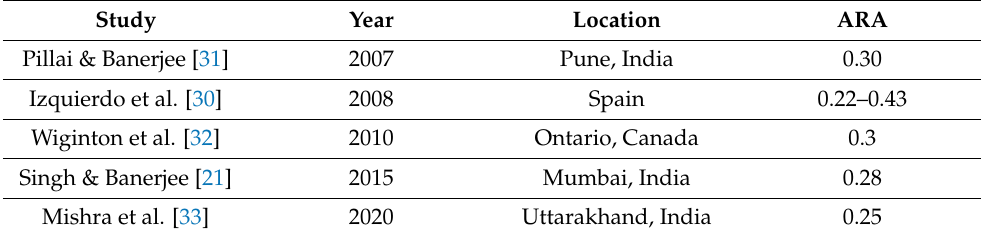
Table 2. ARA coefficients used in the